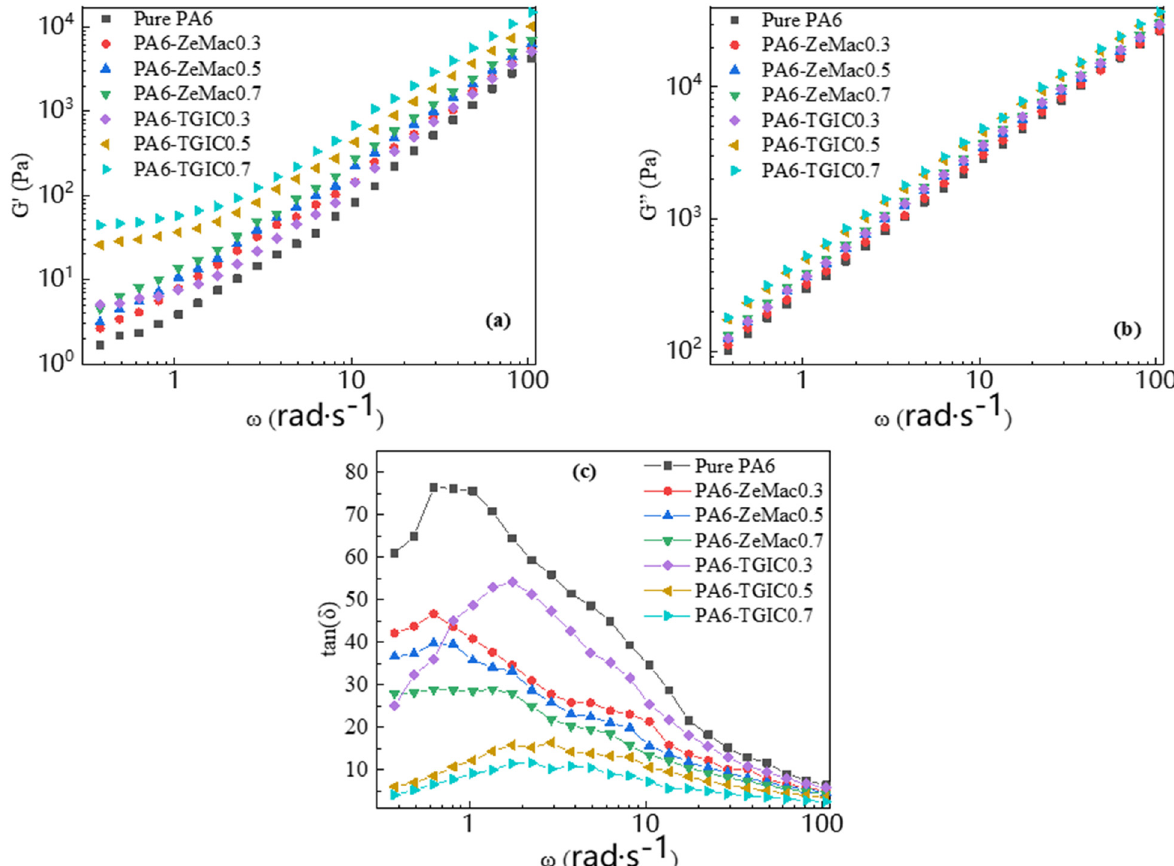
Figure 3: ( a ) The storage modulus G ′ , ( b ) the loss modulus G ″ , and ( c ) the loss tangent tan δ of pure PA6 and modi fi ed PA6